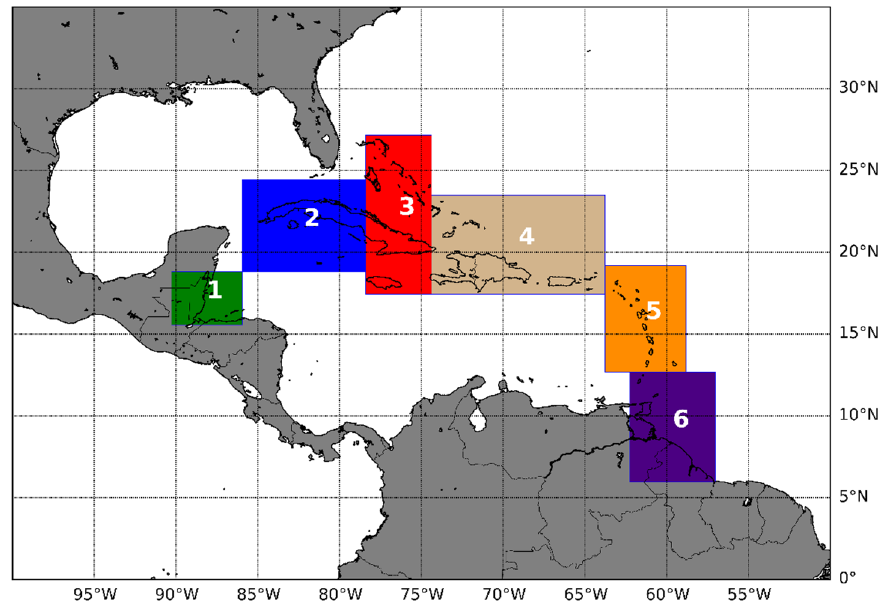
Figure 1. Providing Regional Climate Impact Scenarios (PRECIS) domain and six rainfall zones over the Caribbean. Zone coordinates and countries are shown in Table 2.